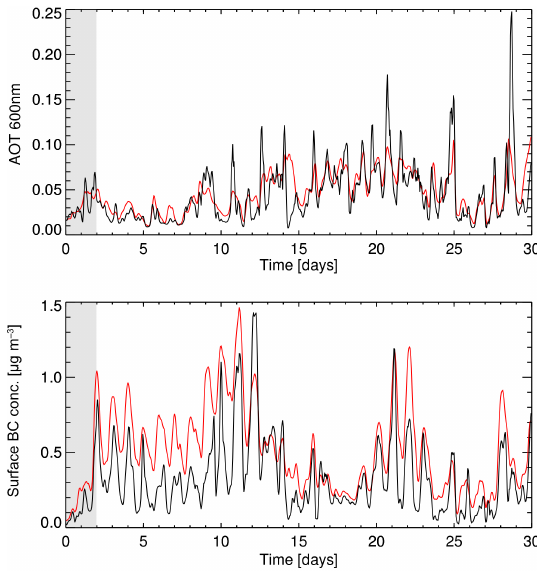
Figure 3. Time series of global model (red) and observed (black) AOT and surface black carbon concentration as simulated at a lo- cation south of Calais (France) by WRF-Chem MADE; see also Fig. 2. The grey area to the left shows the model’s spin-up period.